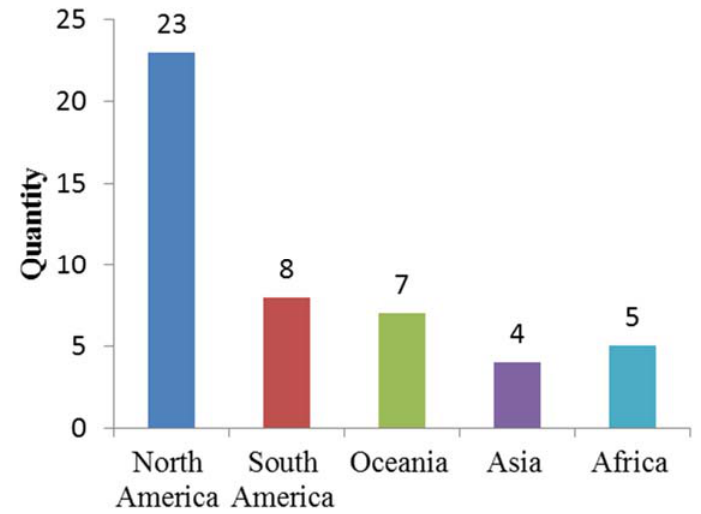
Figure 2. Different intercontinental data distribution.